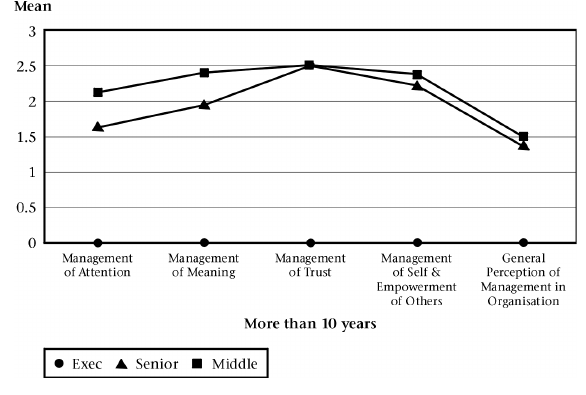
Figure 9: Mean per Dimension per Management Level – More than 10 Years of